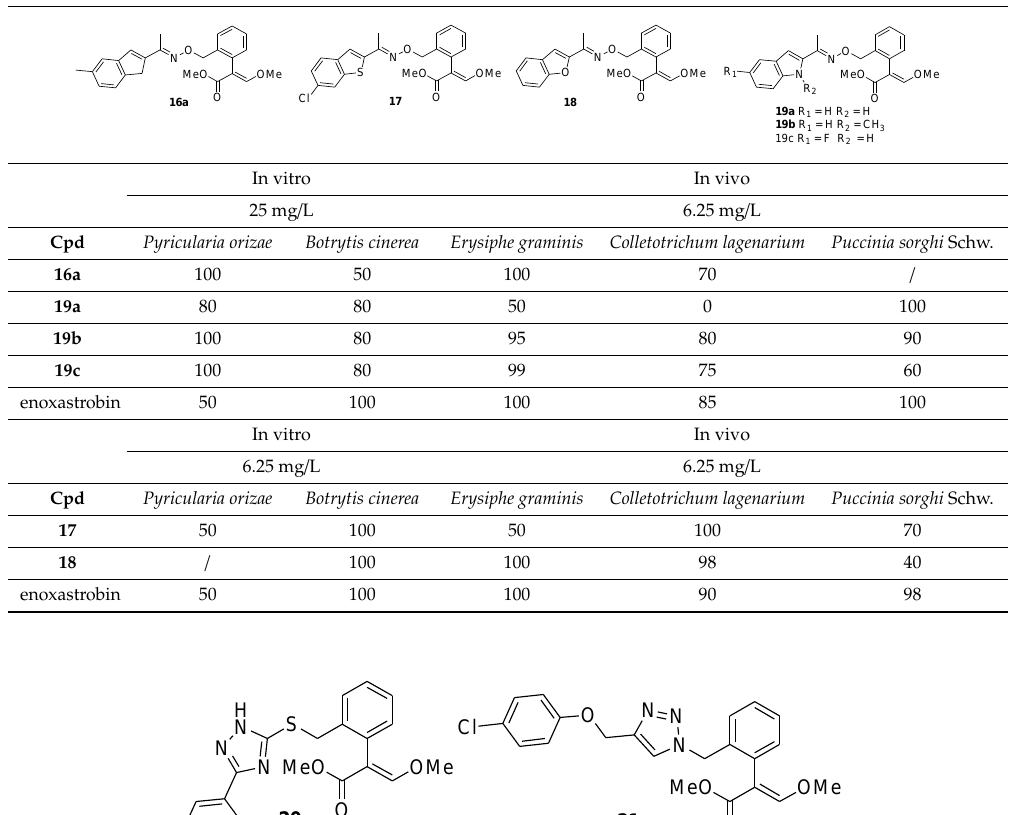
Table 1. In vitro and in vivo fungicidal activity (inhibition %) of representative indene ( 16a ), benzothiophene ( 17 ), benzofuran ( 18 ), and indole ( 19a – c ) -substituted oxime ethers. from References